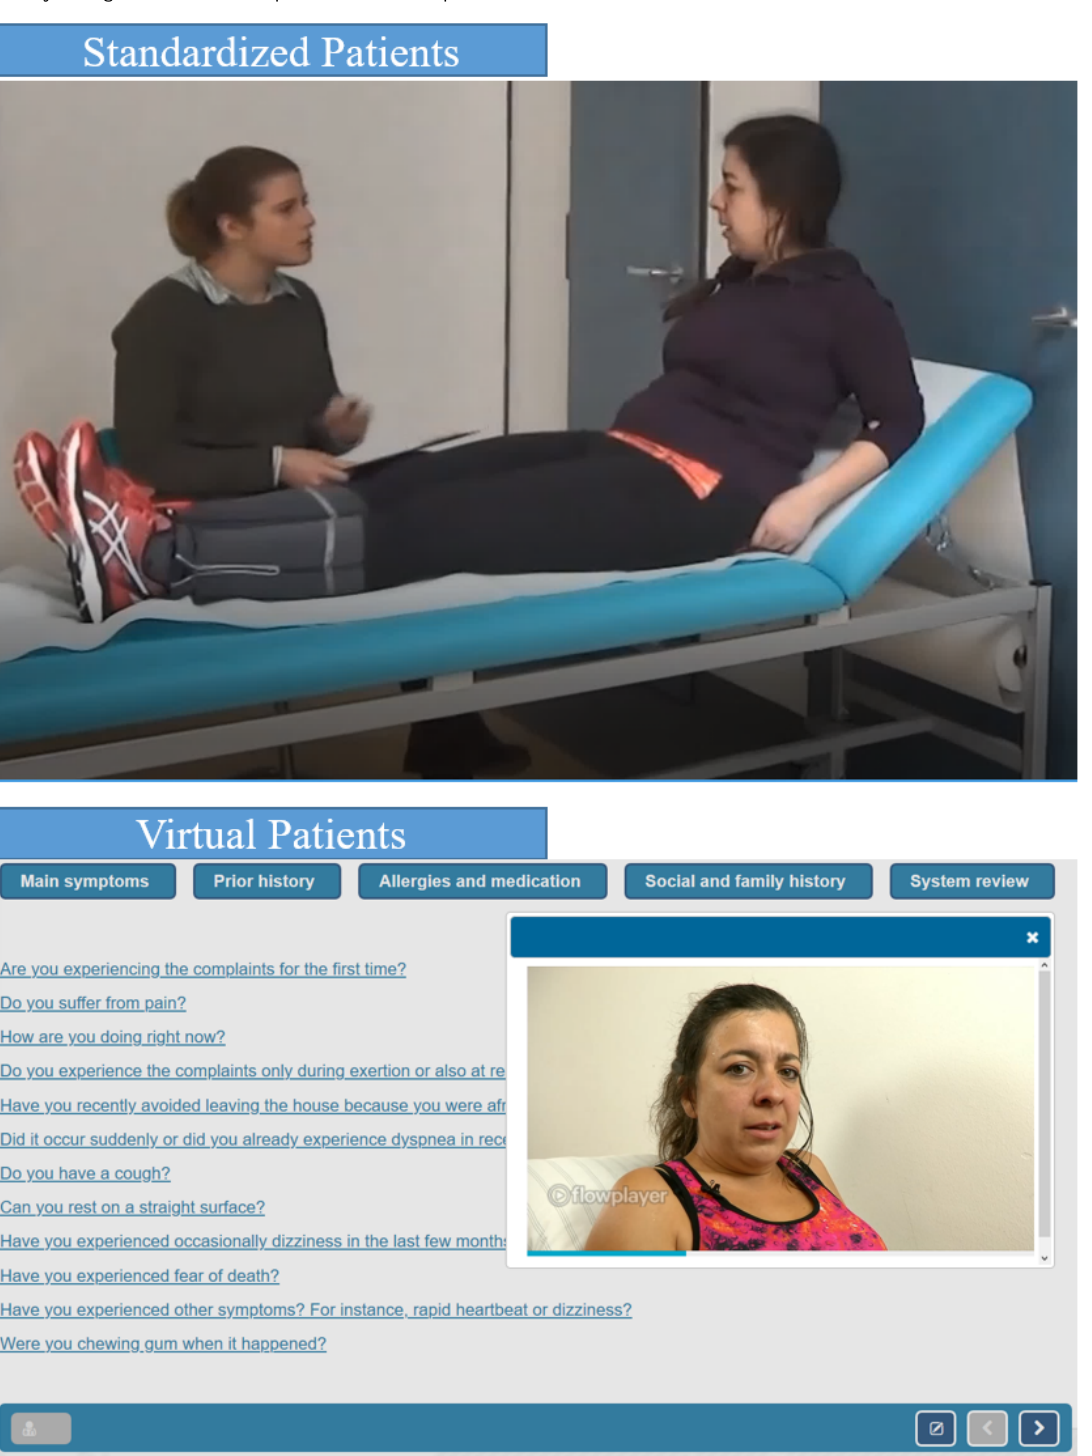
Figure 1. History-taking with standardized patients and virtual